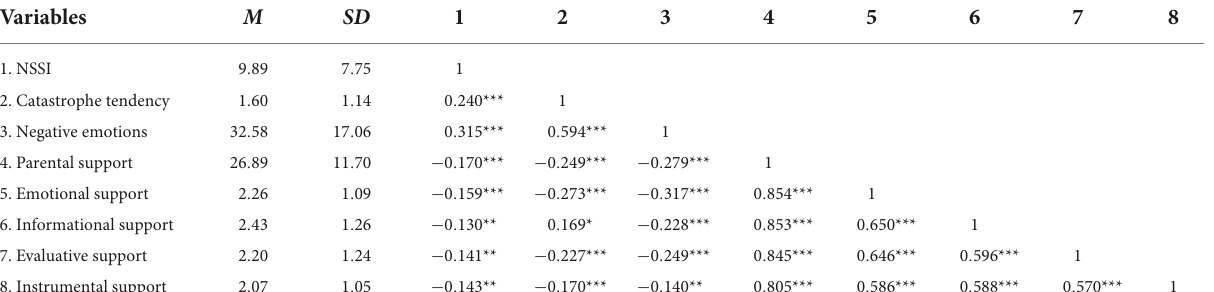
TABLE 1 Descriptive statistics ( N =